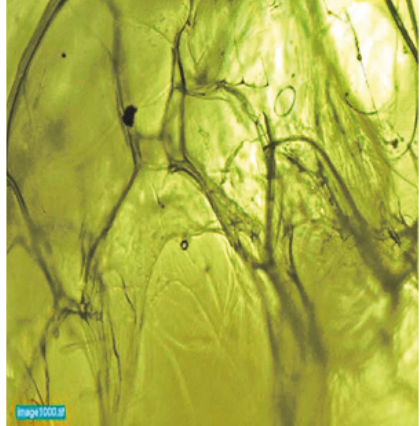
Figure 6: Microscopic image of chitosan/TiO 2 sample.